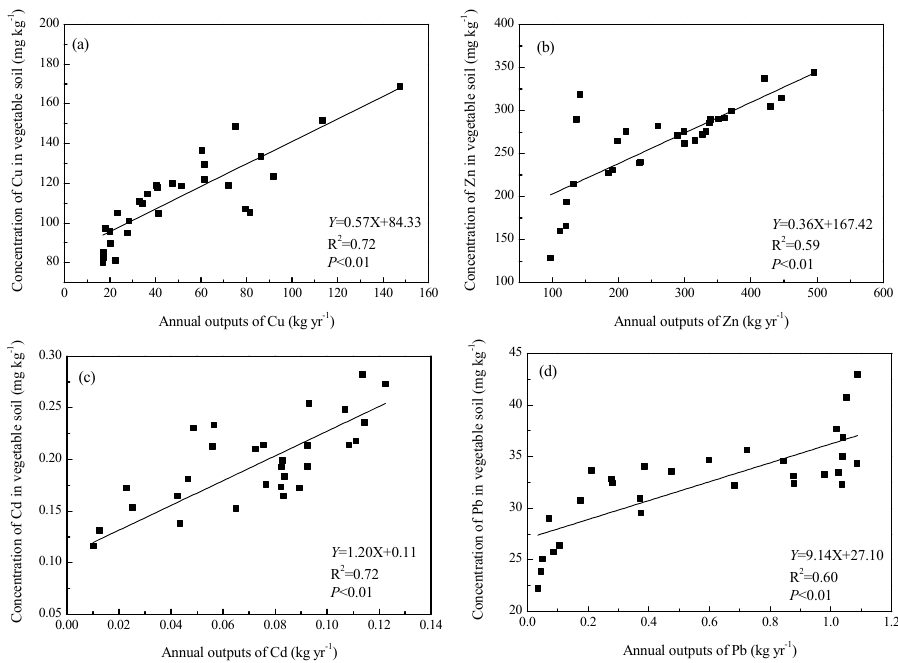
Figure 3. The heavy metals such as Cu, Zn, Cd and Pb in vegetable soil response to the annual outputs of pollutants from pig farms. ( a ) The relationship between annual outputs of Cu and content of Cu in vegetable soil. ( b ) The relationship between annual outputs of Zn and content of Zn in vegetable soil. ( c ) The relationship between annual outputs of Cd and content of Cd in vegetable soil. ( d ) The relationship between annual outputs of Pb and content of Pb in vegetable soil.